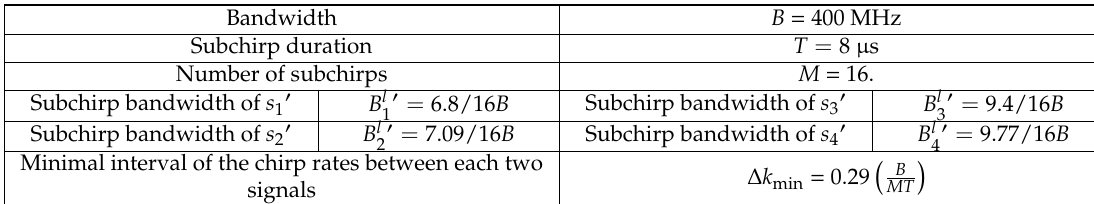
Table 3. Parameters of simulation signals.